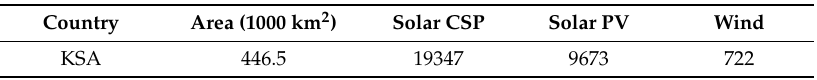
Table 6. Upper limits on installable capacities in Saudi Arabia in units of GW th for CSP and GW el for all other technologies.